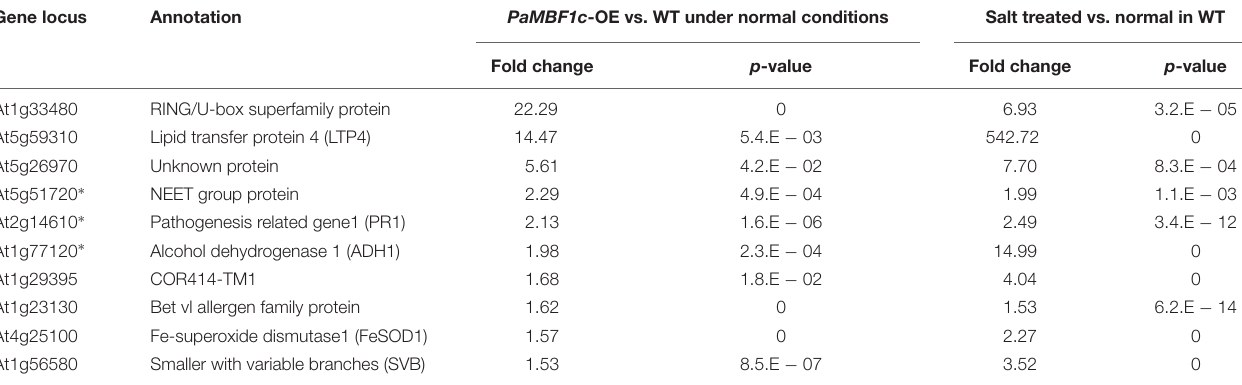
FIGURE 7 | Transcriptome analysis of WT, PaMBF1c -OE, and AtMBF1c -OE lines. (A) Numbers of salt-regulated genes ( p -value < 0.05, FDR corrected p -value < 0.05, absolute value of fold change > 1.5) in WT, PaMBF1c -OE, and AtMBF1c -OE lines. Shaded regions indicate genes commonly regulated by salt in all three lines. Numbers above the pink bars denote the total number of up-regulated genes and ones below the blue bars indicate the total number of down-regulated genes in each genotype. Numbers by the shaded regions in the middle of the bar are the total number of genes that were commonly up-/down-regulated in all variants. (B) Venn diagram showing 10 salt up-regulated genes that were already up-regulated in PaMBF1c -OE and 7 genes in AtMBF1c -OE plants under normal conditions. TABLE 1 | Salt up-regulated genes that were already up-regulated in the PaMBF1 c-OE lines under normal conditions. Gene locus Annotation PaMBF1c -OE vs. WT under normal